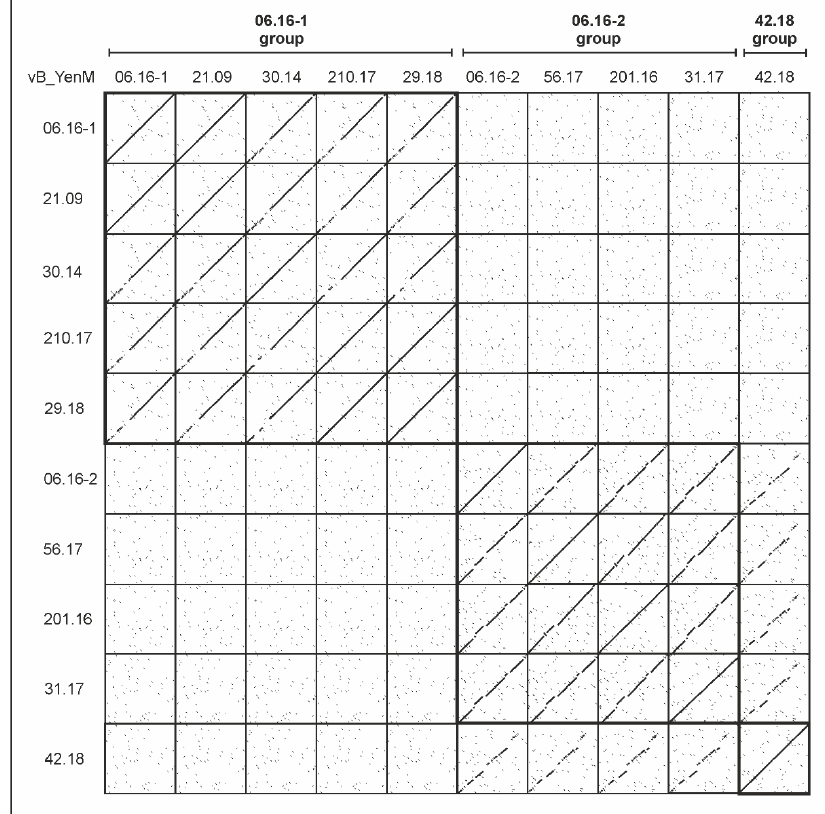
Figure 3. Multi-dot plot alignment of the phage genomes. Dot plot alignments of individual genome combinations were generated using DS Gene (v 2; Accelrys Inc., San Diego, CA, USA) using default parameters (window size 30, hash value 6, min. score 65) and composited to a multi-dot plot using Corel Draw X8 (V 18.1.0.690; Corel Corporation, Ottawa, ON, Canada).